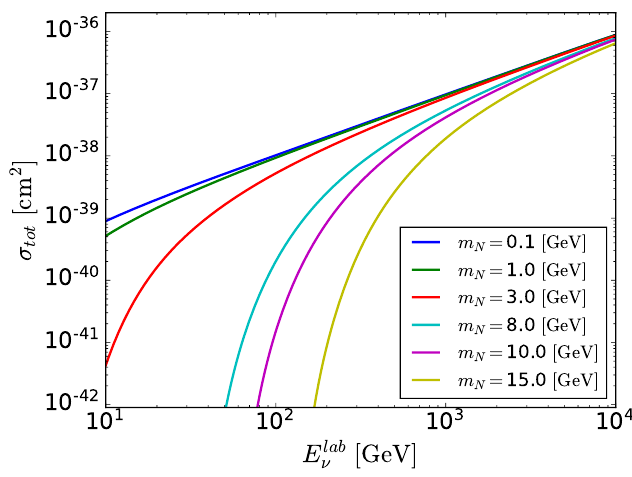
Figure 1 . Cross section of ν µ + nucleon → N + X versus the energy of the initial neutrino for various N mass. We have taken G